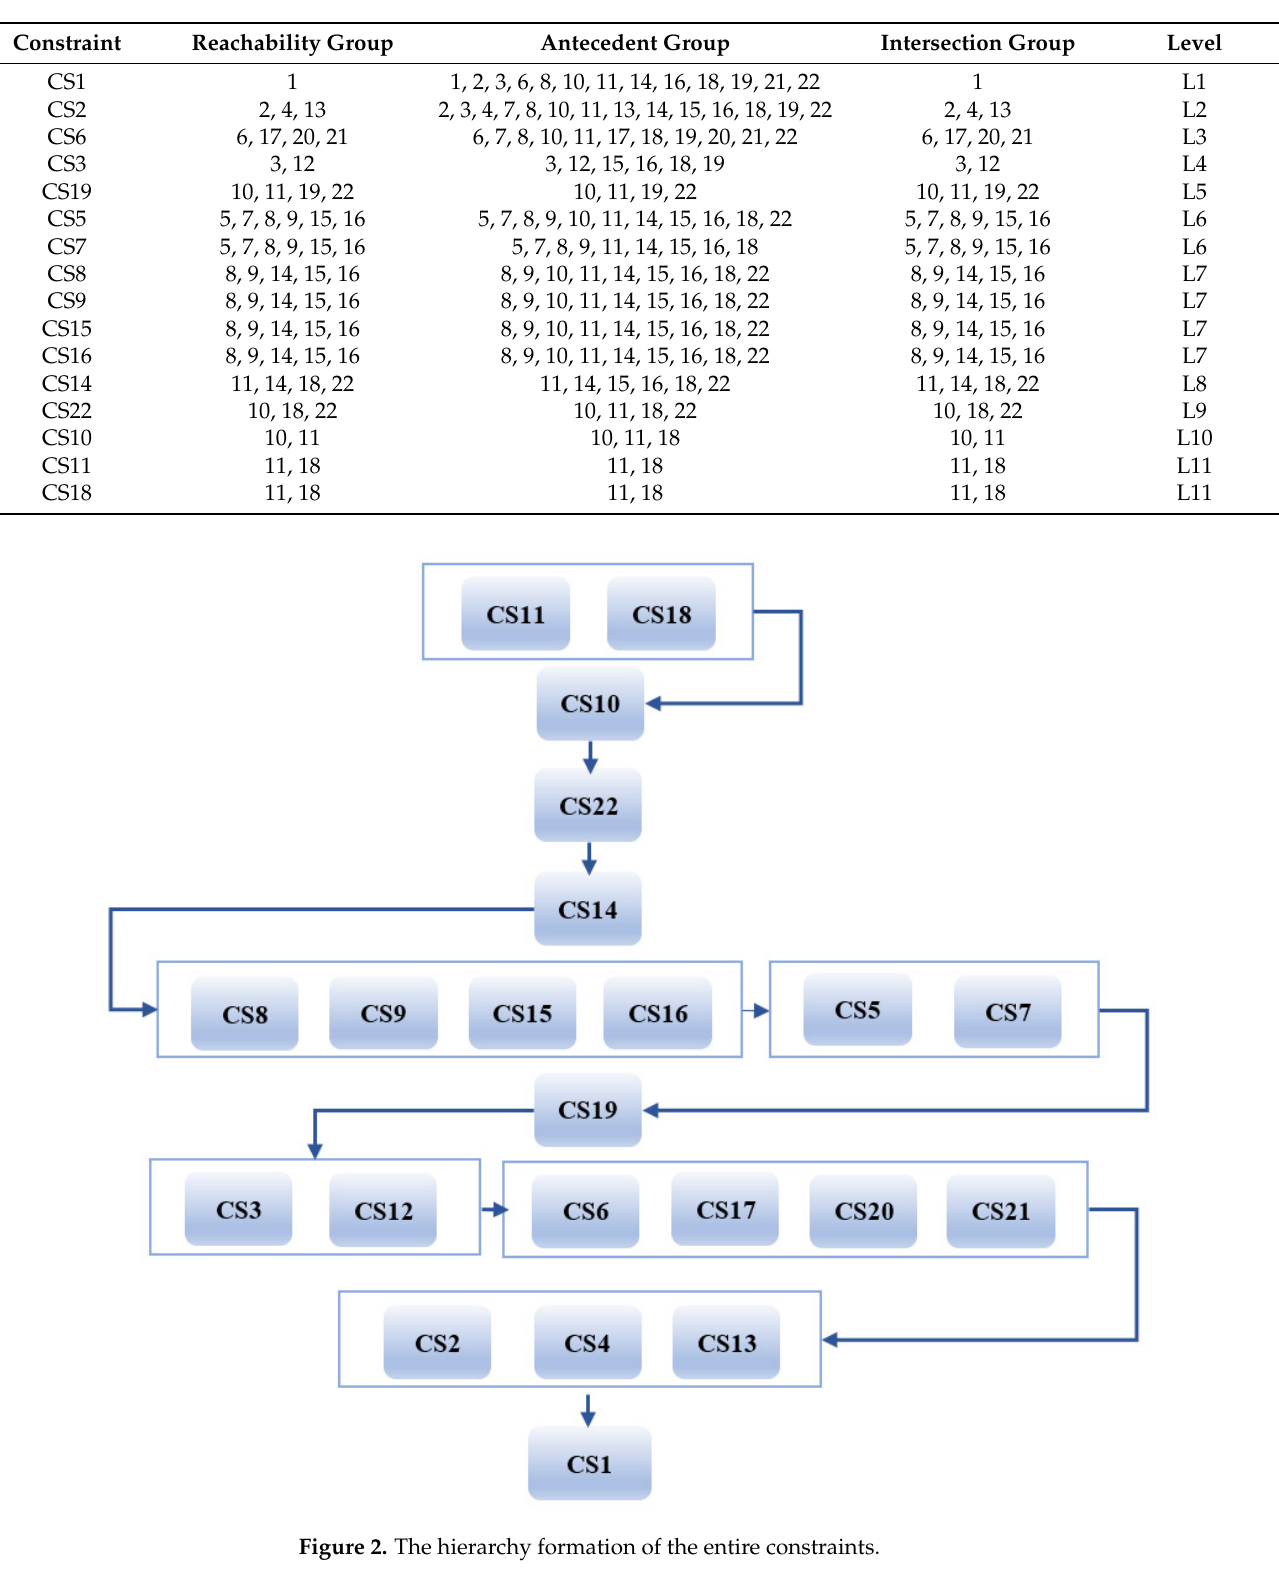
Table 3. Summary of the level segmentation of the final reachability matrix.